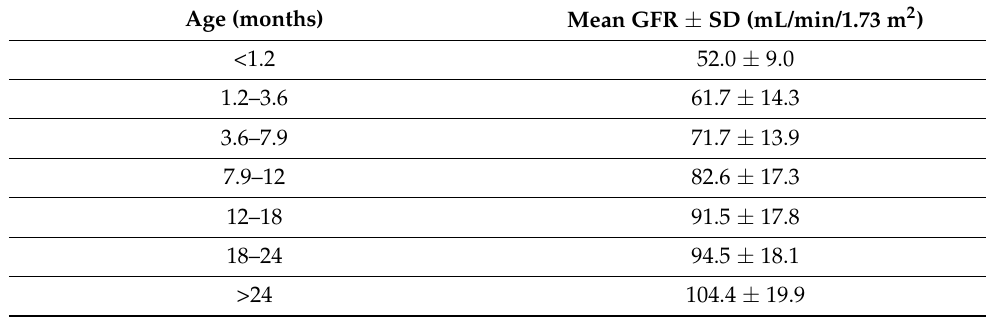
Table 1. Plasma 51Cr-EDTA clearance in normal infants and children. Data form